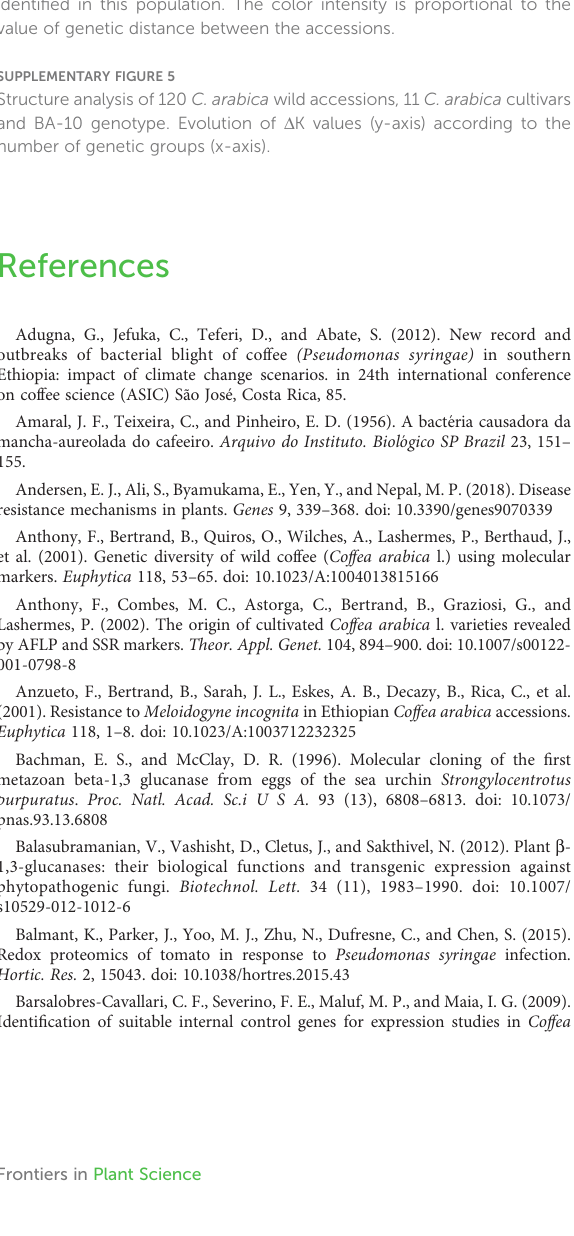
SUPPLEMENTARY FIGURE 6 Classi fi cation of 132 accessions of C. arabica , using 11,290 SNPs identi fi ed in this population, into K = 2, K = 3, K = 4, and K = 5 using STRUCTURE 2.3.4. The distribution of the accessions to different populations is indicated by the color code. Numbers on the y-axis show the subgroup membership, and the x-axis shows the different accessions. SUPPLEMENTARY FIGURE 7 Population structure and relation with resistance to BHB. The distribution frequency of the QTNs associated with resistance to BHB into the “ cultivars ” (n = 16), “ domesticated ” (n = 20), and “ wild ” (n = 33) clusters identi fi ed in population structure Bayesian approach at K = 3. C. arabica Ethiopian accessions classi fi ed as admixed were disregarded in this analysis. QTN associated with resistance to BHB with its respective location in the C. arabica Et039 genome1; QTN effect2; r2 (%) of the QTN in relation to the resistance phenotype3. SUPPLEMENTARY FIGURE 8 Transcribed levels in the absence of the pathogen. (A) The g000 (Chr_0_434_435) and (B) g010741 (Chr_2_sg_E). Data represent the means± standard deviation. Upper case letters compare columns of different genotypes. Same letters show no difference by Tukey test (for P ≤ 0.05). SUPPLEMENTARY FIGURE 9 Model for PTI-inhibition and ETI-induction by Pseudomonas syringae effector. In susceptible plants, the effectors bind to PRRs. This blocks PTI activation and enhances host susceptibility to the bacterium. In resistant plants, serine/threonine – kinase isevolvedto mimicthe kinasedomainof PRRs and binds to the effectors to trigger ETI, resulting in a resistance outcome. Blocking (A) and triggering (B) a hypersensitive response by Pseudomonas syringae